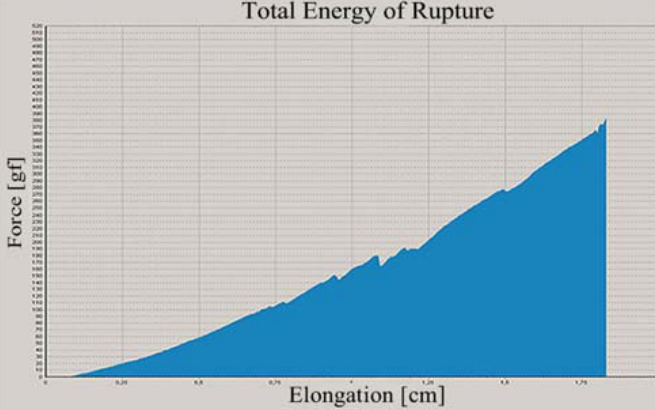
FIGURE 2 - Graph Force (gram force) x Elongation of rupture (cm). The area under this function represents the total energy of rupture